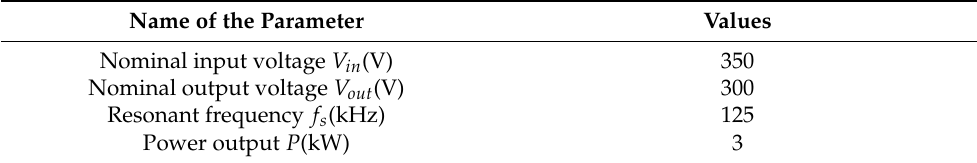
Table 1. Design parameters of full-bridge CLLC resonant converter.